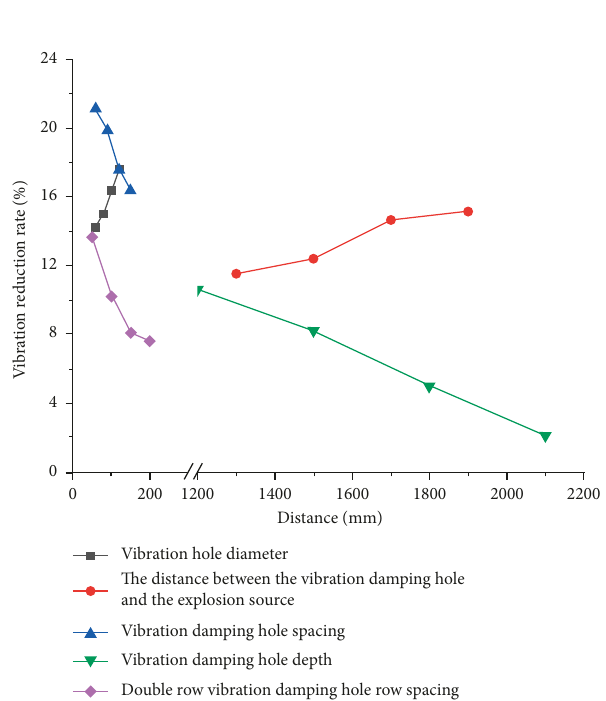
Figure 11: Each factor and the corresponding damping rate.